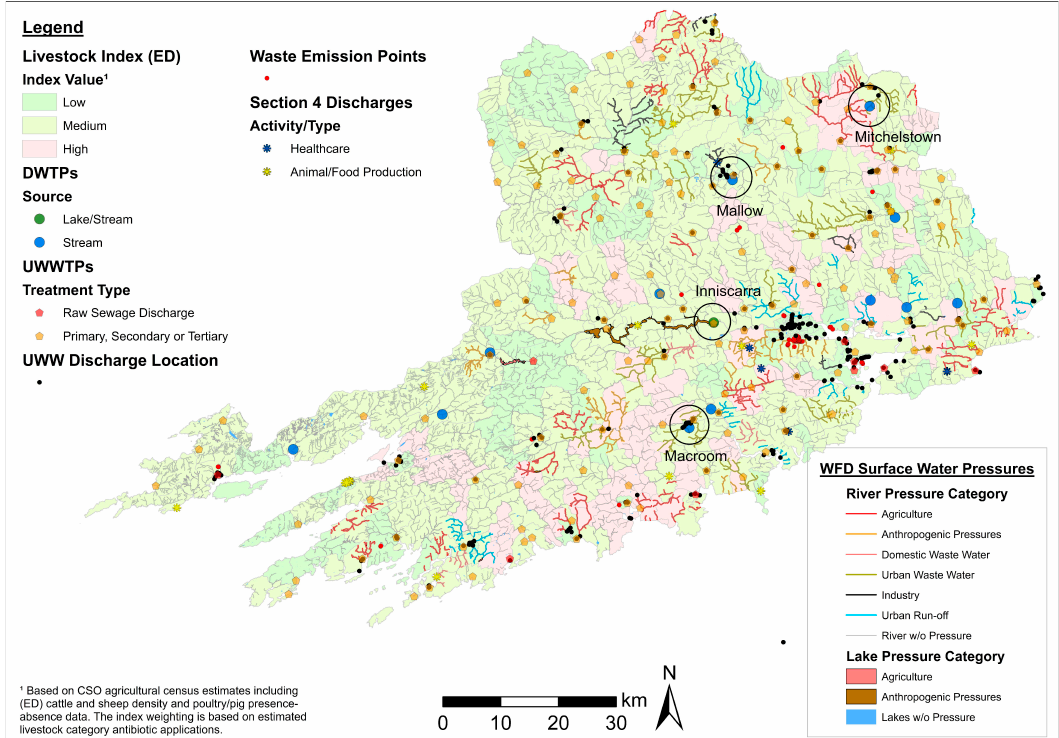
Figure 9. Map of drinking water treatment plants (DWTPs) and selected ARO sources in County Cork. Notes: EPA-WFD rivers/lakes significant pressures and livestock index estimates data layers are included. Relevant DWTPs are delineated with a buffer. ED = electoral district. UWWTPs = urban wastewater treatment plants. UWW = urban